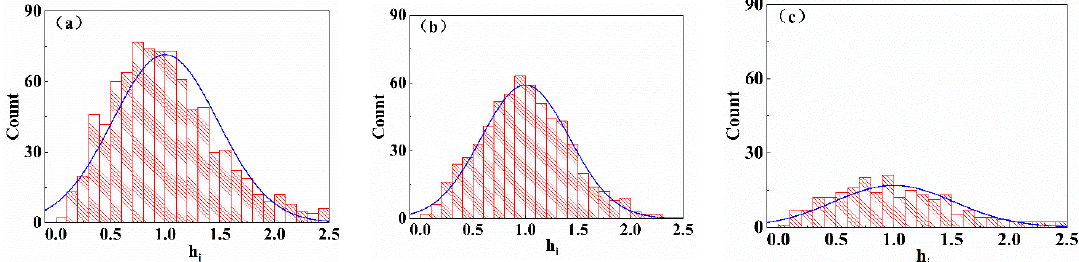
Figure 3. Relative height distributions of the three typical pyramidal textures: ( a ) Initial etching, ( b ) moderate etching, ( c ) excessive etching (the relative height is within the range of 0–2.5, and the number of pyramids near the mean value 1 is the highest.)